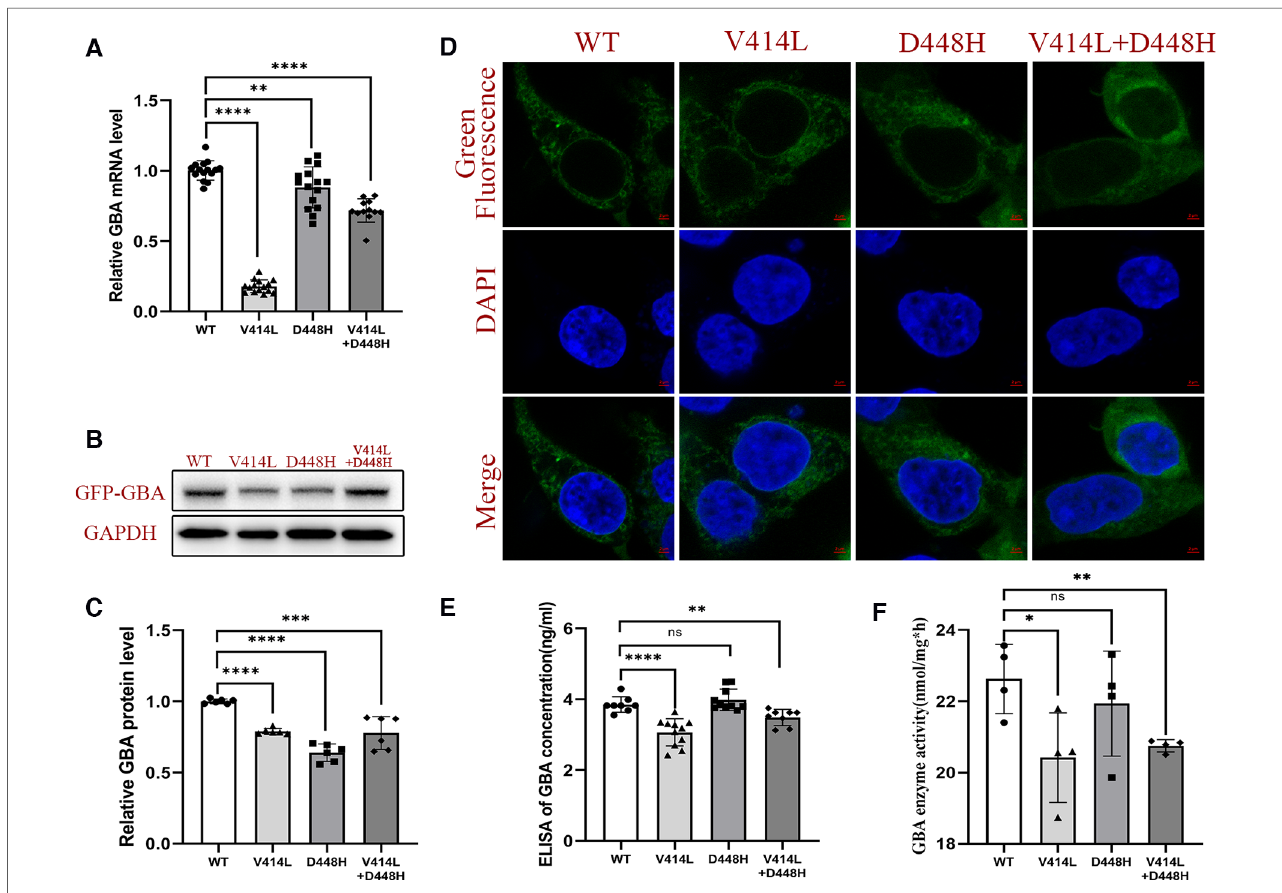
FIGURE 4 Functional analysis after plasmid transfection. ( A ) mRNA expression level of GBA1 in HEK293T cells. There was a signi fi cant difference in the mRNA level of the wild-type and the mutant. ( B ) Western blotting analysis of GCase expression. ( C ) Protein expression level of GCase in HEK293T cells. Quantitative detection found that the WT GBA1 was more highly expressed than the MT at both the mRNA and protein levels ( p <0.05). ( D ) The subcellular localization analysis showed that both the MT and WT were localized at the cytoplasm. ( E ) The GCase concentration was signi fi cantly different between the WT and the V414L mutation or V414L +D448H. ( F ) The GCase enzyme activity assay was signi fi cantly different between the WT and the V414L mutation or